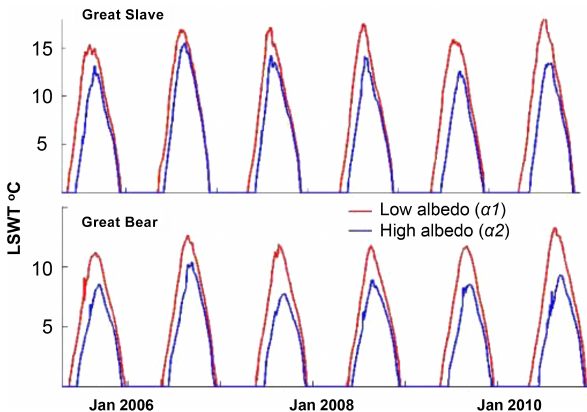
Figure 16. Lake surface water temperatures (LSWTs) for Great Bear (66 ◦ N, 121 ◦ W) and Great Slave (62 ◦ N 114 ◦ W) mod- elled with low snow and ice albedo (default albedo, α 1: snow and white ice = 0.60 and melting snow and blue ice = 0.10) and high albedo ( α 2: snow and white ice = 0.80 and melting snow and blue ice = 0.60) demonstrating that the higher snow and ice albedo delays the 1 ◦ C warming day, causing a lower July–August– September LSWT.